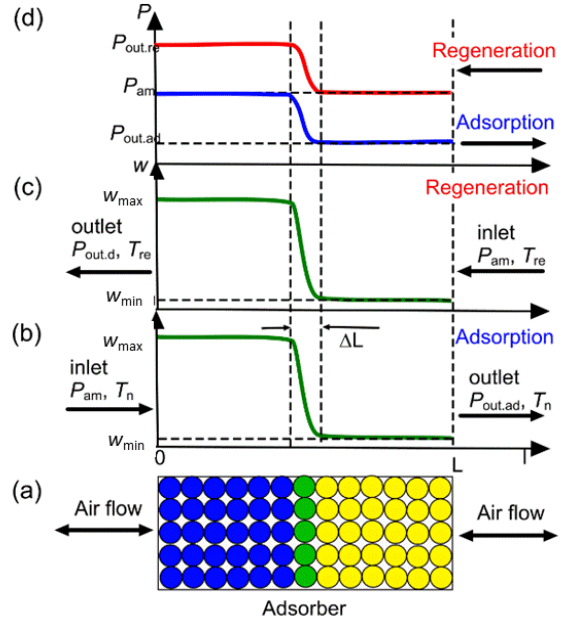
Figure 9. Scheme of a fixed-bed flowing adsorber ( a ) and distribution of water uptake ( b , c ) and vapor partial pressure ( d ) along the adsorber.